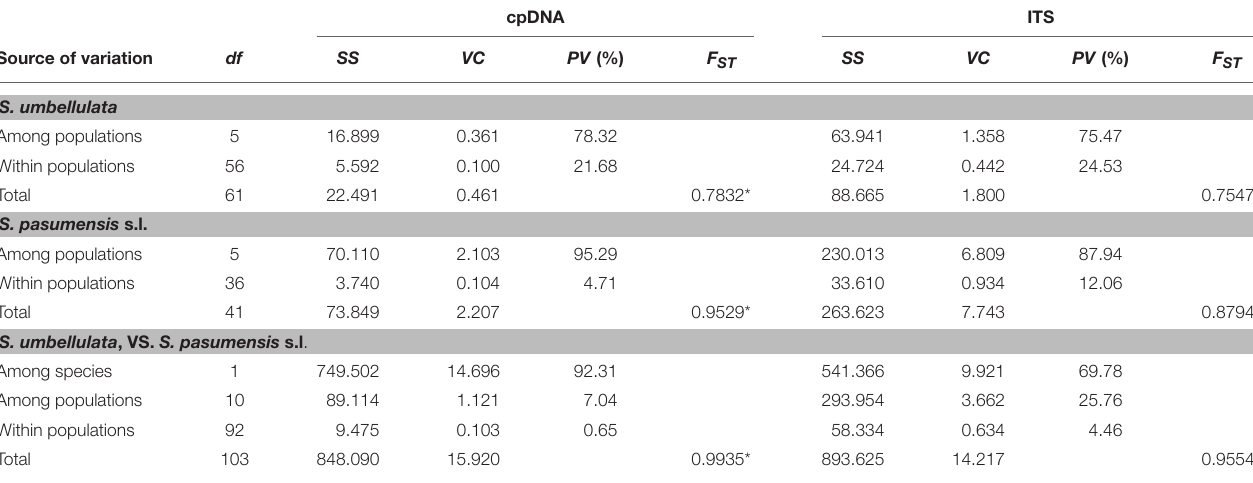
TABLE 3 | Analysis of molecular variance (AMOVA) of cpDNA haplotypes and ITS genotypes for populations of Saxifraga umbellulata and S pasumensis s.l. cpDNA ITS Source of variation